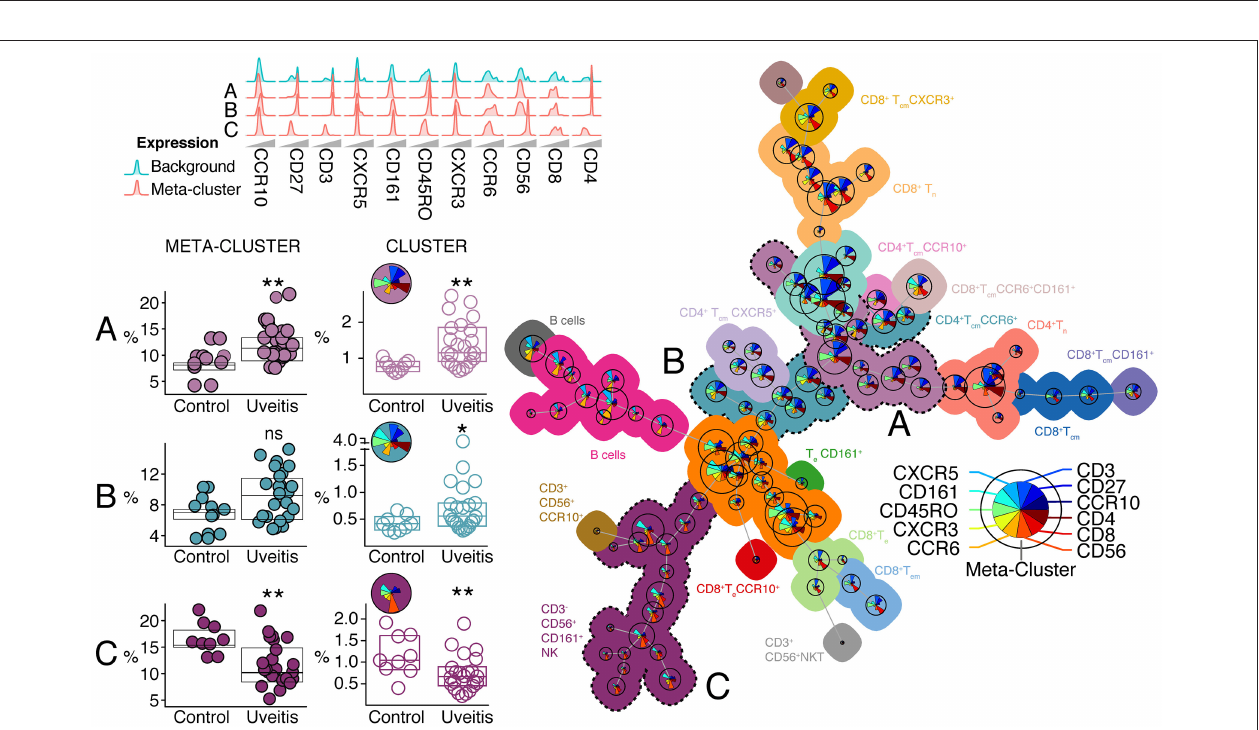
FIGURE 7 | Automatic gating by unsupervised clustering using FlowSOM identifies cell (meta) clusters associated with non-infectious uveitis. Using FlowSOM, we clustered all individual cells within the single-cell gates of all samples into 100 distinct clusters based on the surface protein expression. Using unsupervised clustering, the 100 clusters were clustered into 22 meta-clusters of different cell types and organized in the minimal spanning tree on the right. The meta-clusters are represented by unique colors (all meta-cluster comparisons between uveitis and controls are provided in Figure S3 ). For each cluster (i.e., cell population), pie charts indicate the relative expression for each of the different surface markers and the pie size corresponds to the average size of the population in the samples. Three clusters and their associated meta-clusters (A–C) are indicated. P -values between HC and UV are from Wilcoxon rank-sum test (* P < 0.05, ** P < 0.01, ns, non-significant). For these three meta-clusters, the relative densities of normalized expression of the surface protein markers for from the T cell panel are indicated above and for each associated cluster the pie charts provide the relative expression of each surface marker.